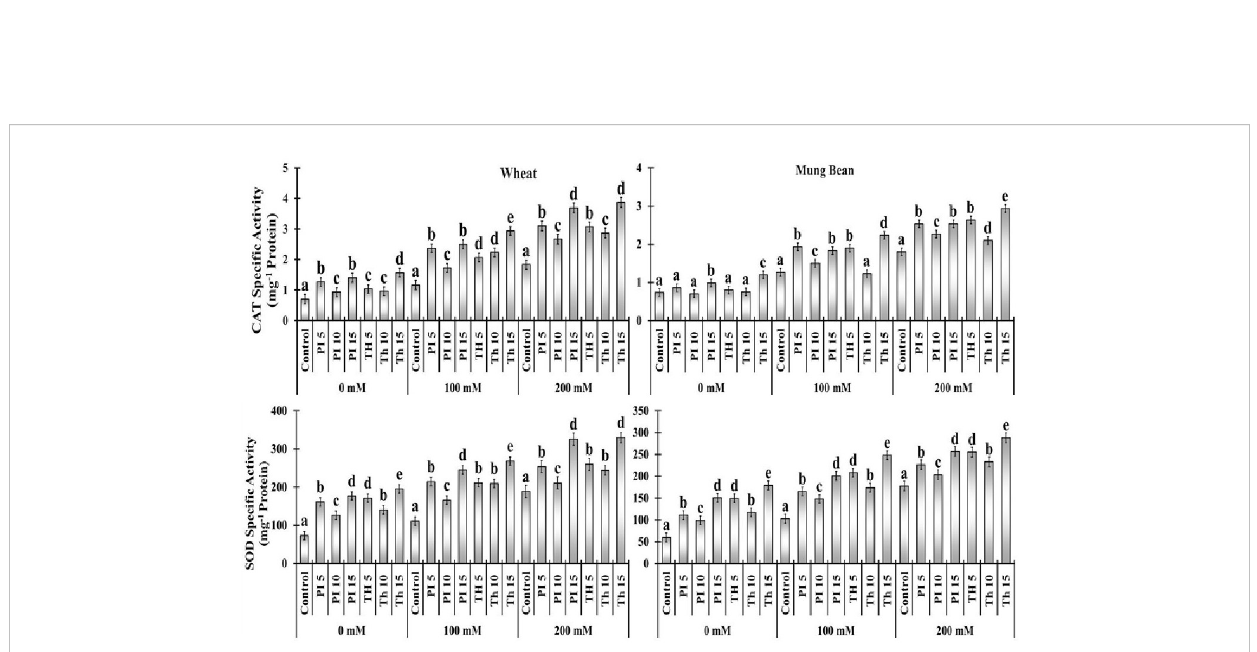
FIGURE 6 Effects of bio-priming with fungal endophytes on Catalase Speci fi c Activity (CAT) and Superoxide Dismutase Speci fi c Activity (SOD) contents of wheat and mung bean grown under saline environment. The symbols on the horizontal axis represents: Control: Seeds without priming, Pl = Seed priming with Paecilomyces lilacinus , Th= Seed priming with Trichoderma hamatum 5, 10, 15 = duration of bio-priming in minute, 0, 100 & 200 mM NaCl concentration. On bars, vertical lines represent ± Mean Standard Error (S.E) and similar alphabets represents non-signi fi cant difference between the means of treatment at p<0.05